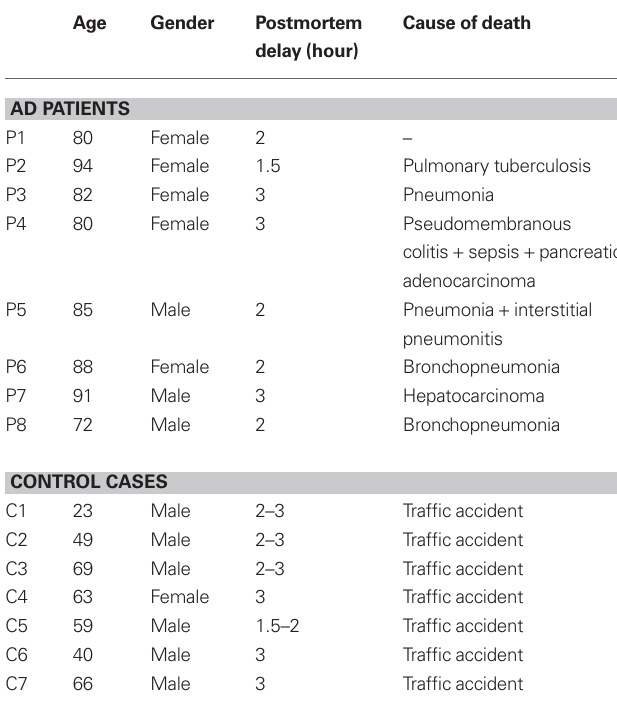
Table 1 | Summary of case